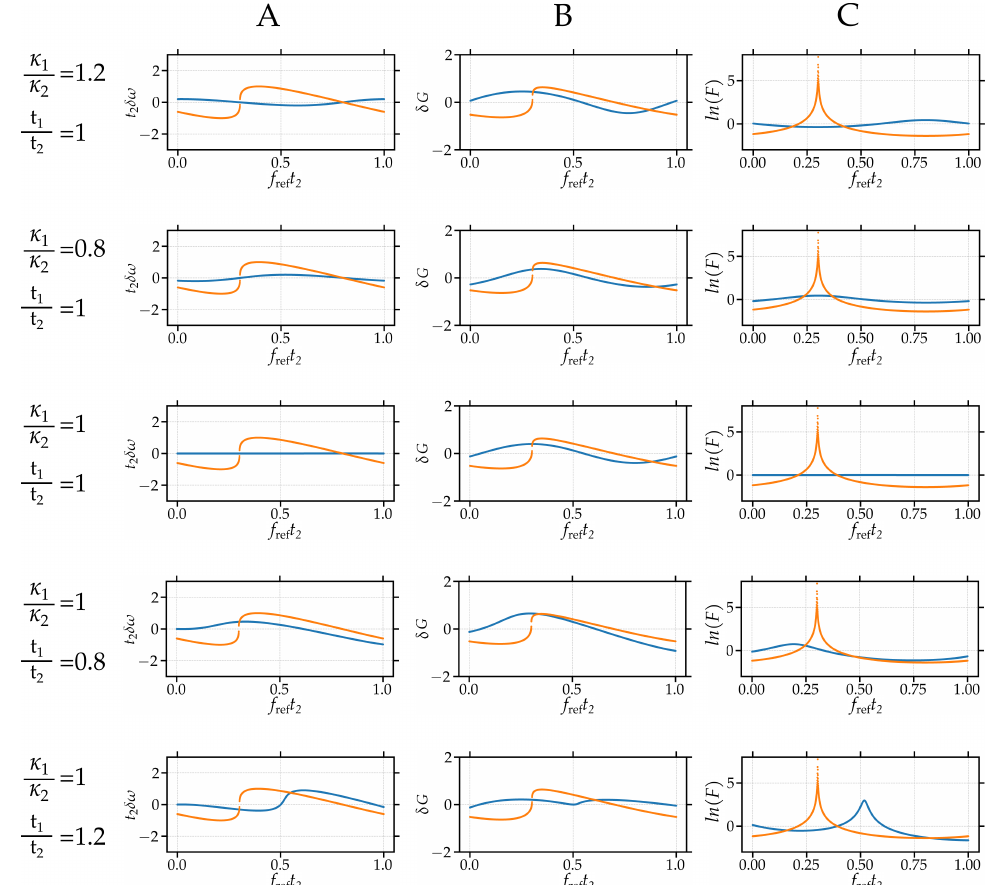
Figure A3. Numerical solutions for C = 1 under condition (12) for a ± 20% variation of conditions (8) and (11). Double feedback case shown in blue, single feedback case shown in orange. Column ( A ) shows the lasing frequency shift results. Column ( B ) shows the threshold gain shift. Column ( C ) shows the intrinsic linewidth